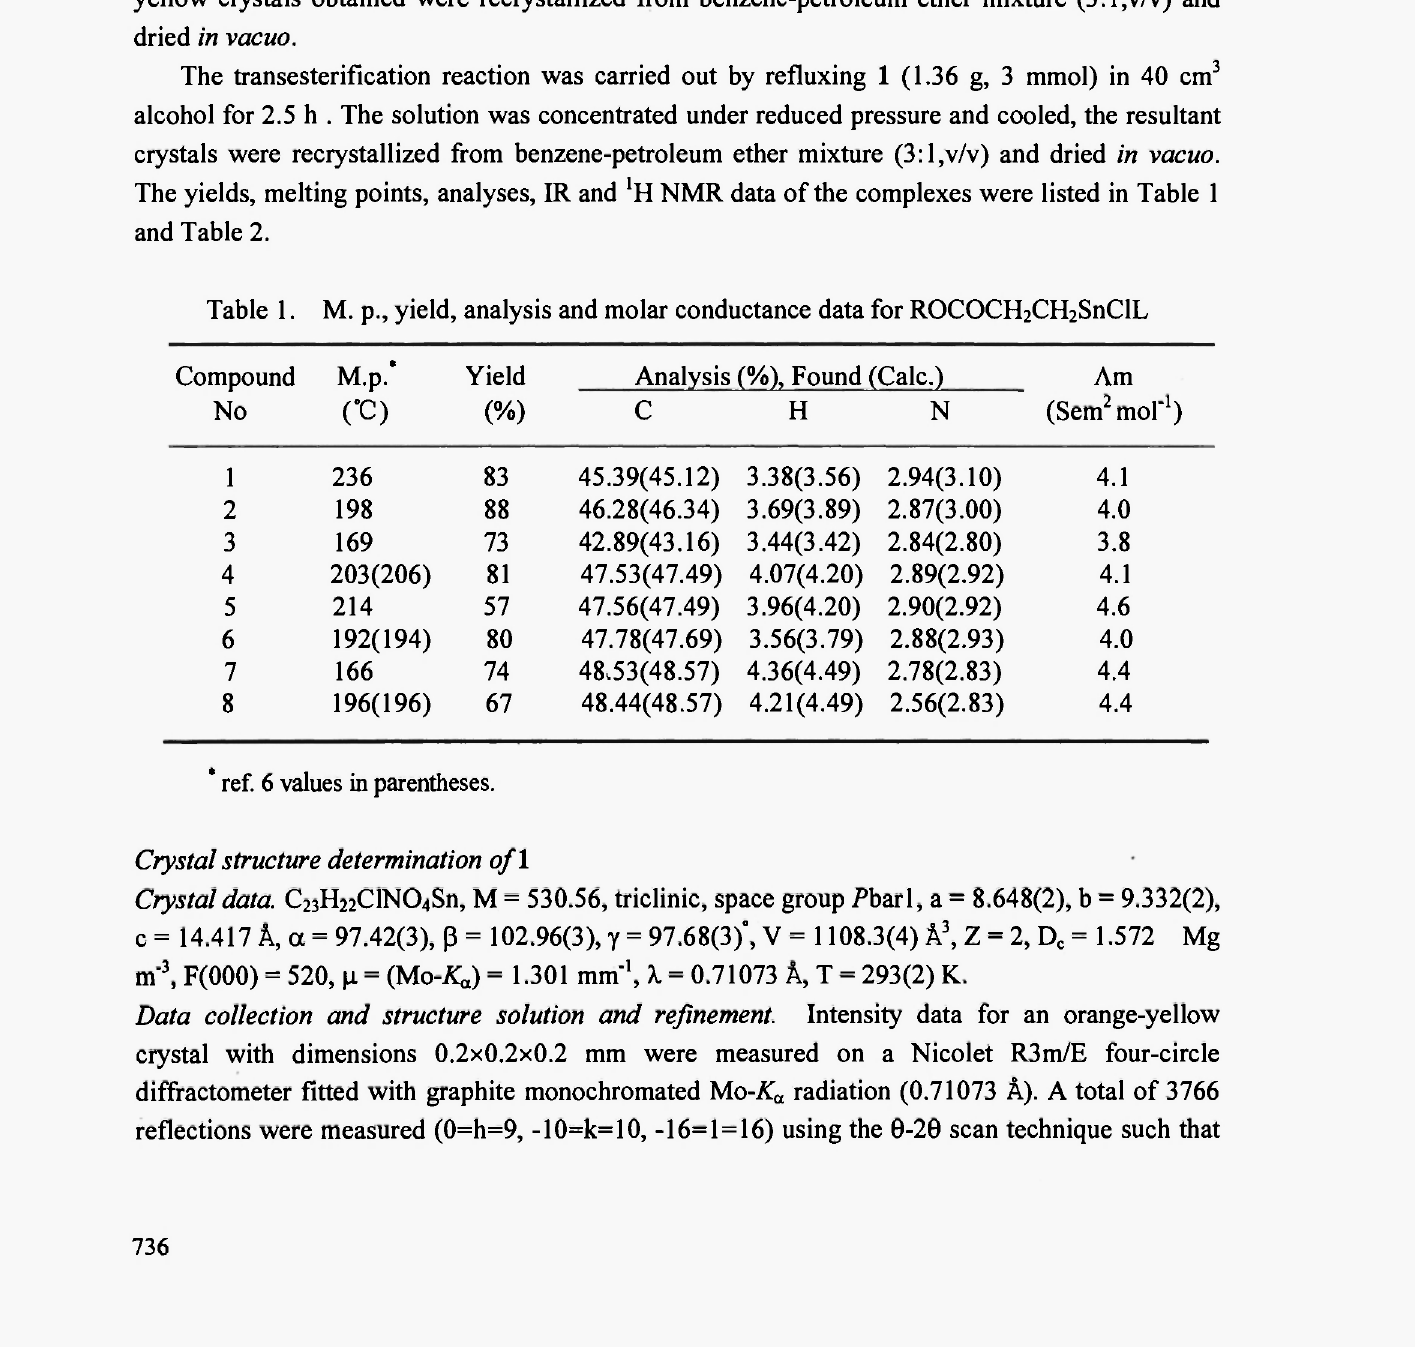
M. p., yield, analysis and molar conductance data for ROCOCH